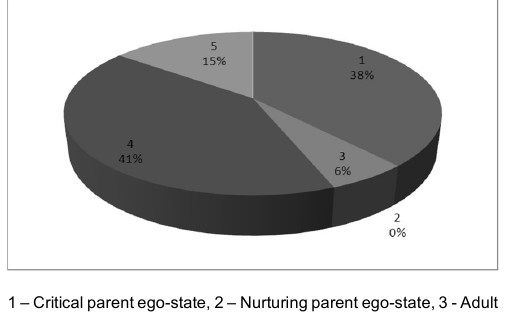
Figure 1. Distribution of dominant functional ego- states of studied patients with paranoid form of schizophrenia